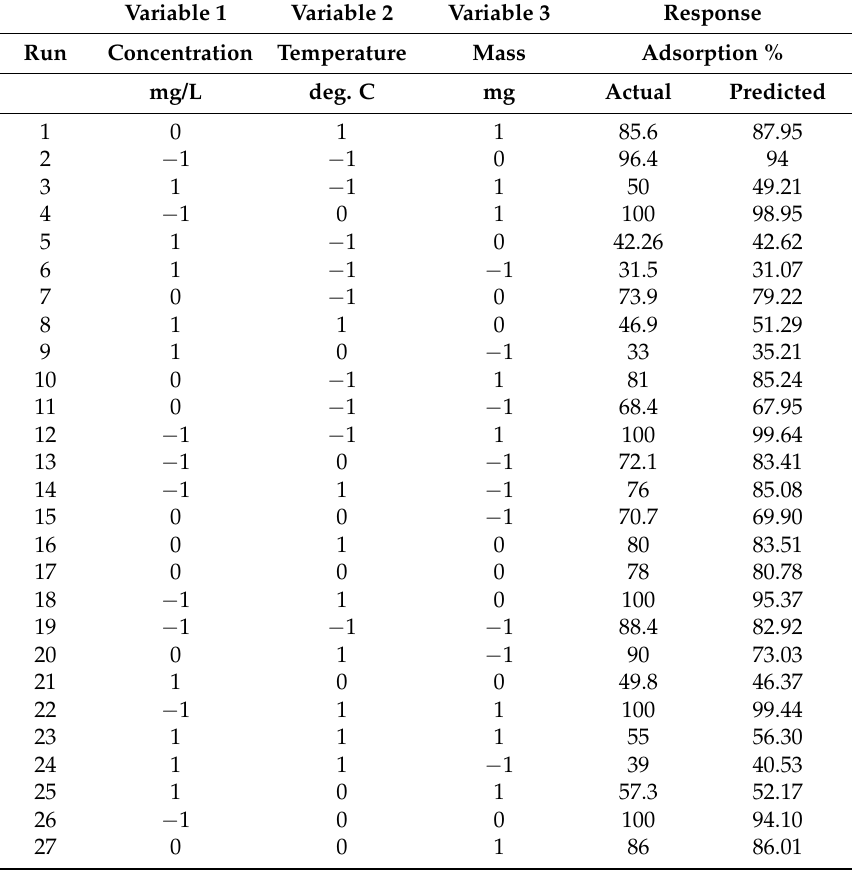
Table 4. Response: actual and predicted